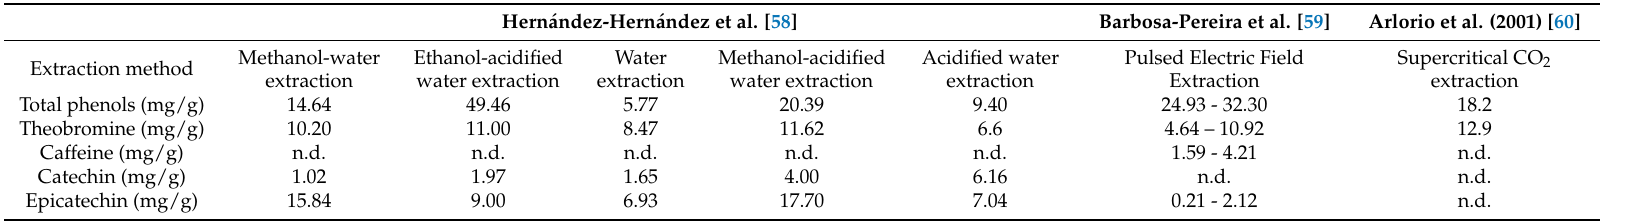
Table 1. The most abundant bioactive components in cocoa shells. n.d.—not determined in the